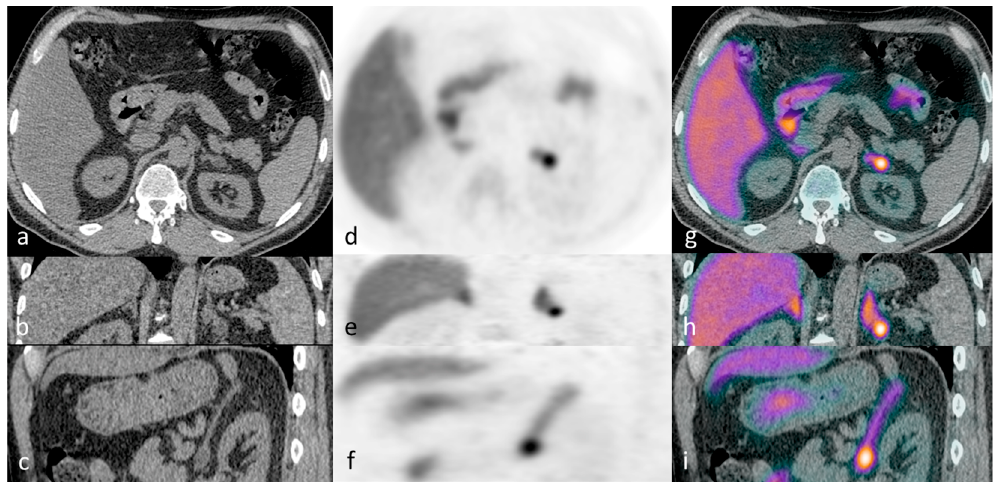
Figure 2. Illustrative case 2: A 55-year-old man with a five-year history of refractory hypertension and hypokalaemia (requiring four agents for blood pressure control) was diagnosed with primary aldosteronism (PA); CT demonstrated a 16mm left adrenal nodule ( a – c ), which was 11 C-metomidate avid, confirming unilateral PA ( d – i ). Functional imaging was performed after right adrenal vein cannulation had been unsuccessful during adrenal vein sampling. A left laparoscopic adrenalectomy confirmed a typical Conn’s adenoma. Three years post-operatively his PA remains in complete remission and he requires only a single agent (amlodipine) to achieve full blood pressure control.